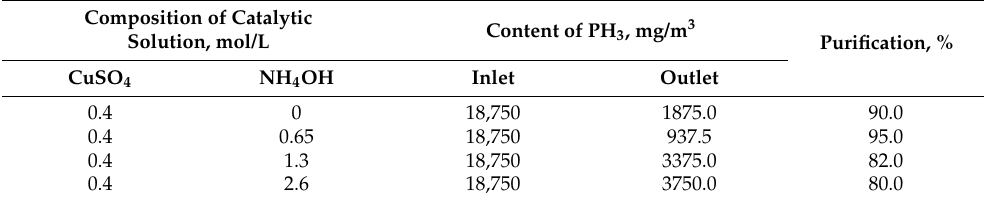
Table 1. The effect of NH 4 OH content on the extent of purification from PH 3 at t = 50 ◦ C, V PH3 = 40 mL/min.